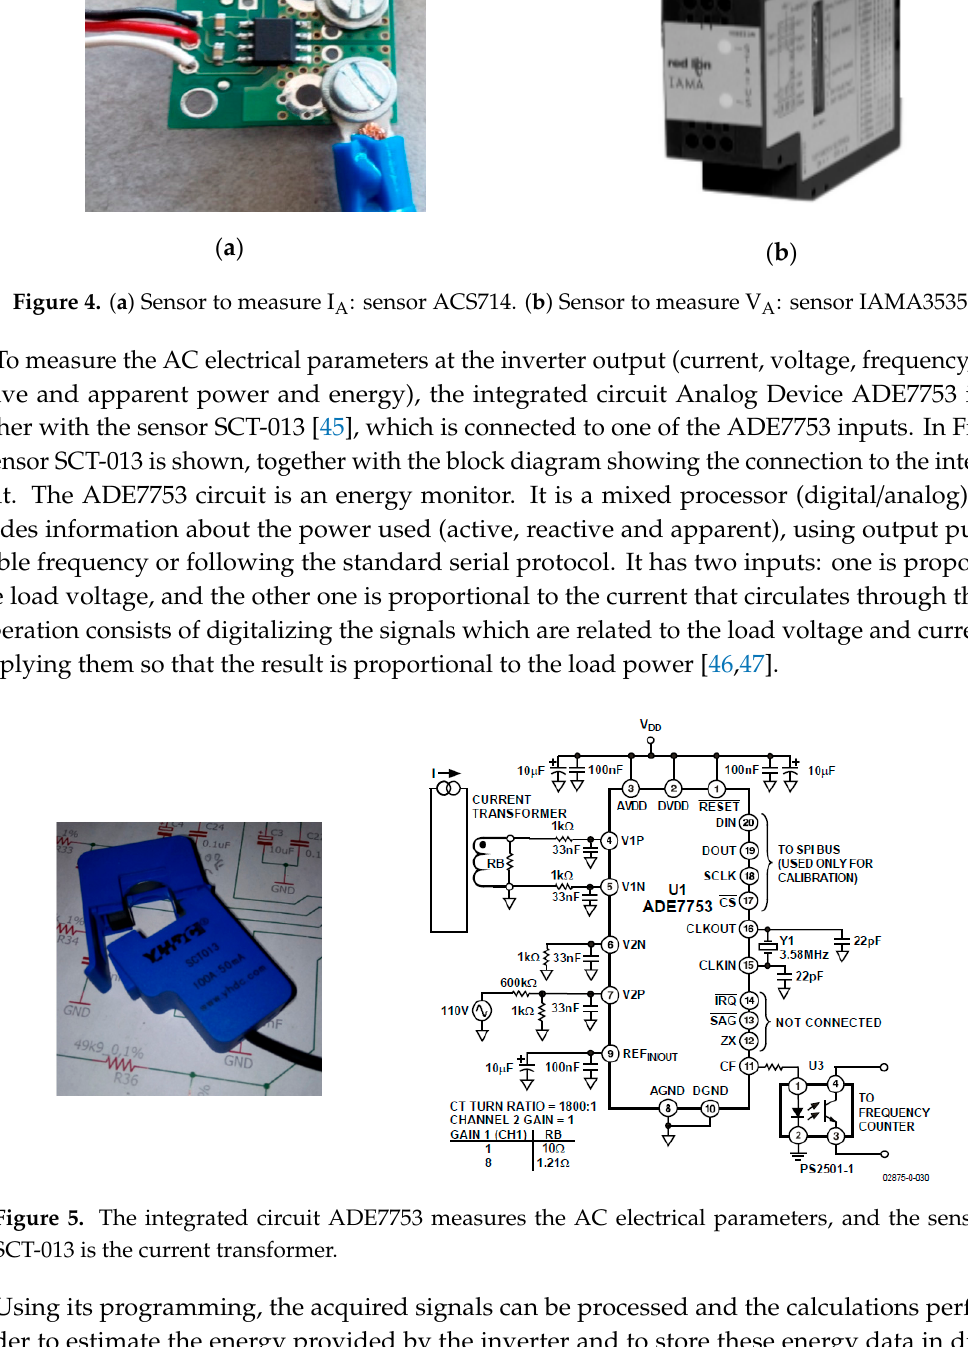
SCT-013 is the current Figure 5. The integrated circuit ADE7753 measures the AC electrical parameters, and the sensor SCT- 013 is the current transformer.